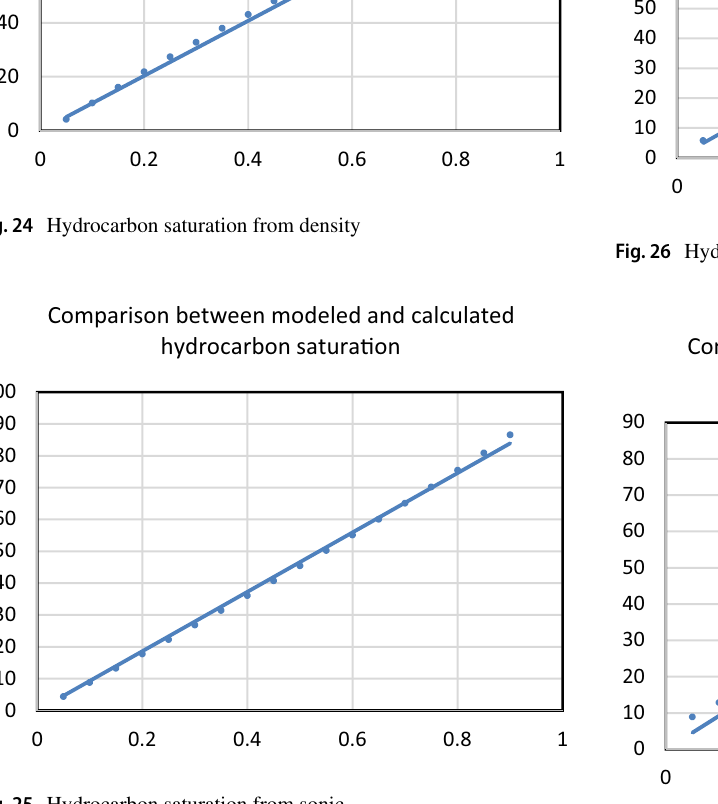
Fig. 27 Hydrocarbon saturation from